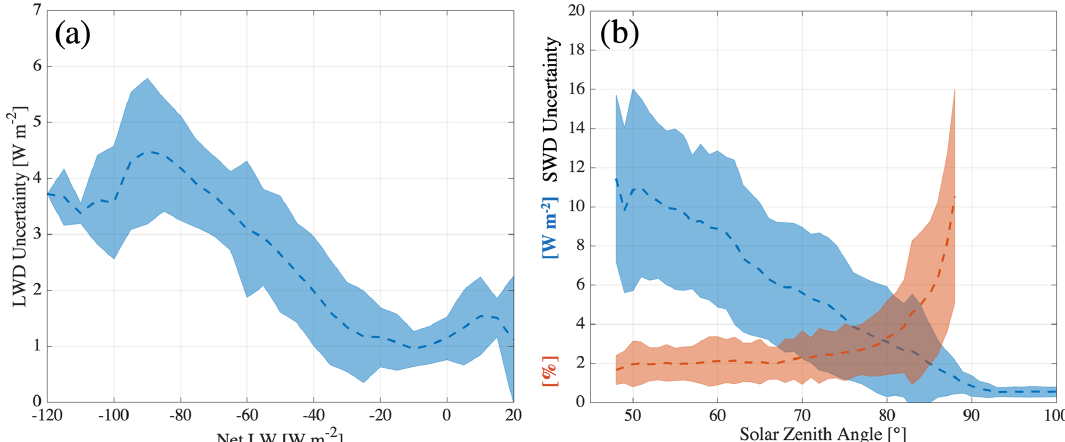
Figure 3. (a) Mean (dashed line) and 1 σ (shading) variability in calculated 1min average uncertainties for LWD as a function of the net longwave flux represented by the mean thermopile flux of the pyrgeometers. (b) Similar to (a) for uncertainty in SWD plotted against solar zenith angle. Uncertainties in (b) are plotted in units of Wm − 2 (blue) and relative units (red).